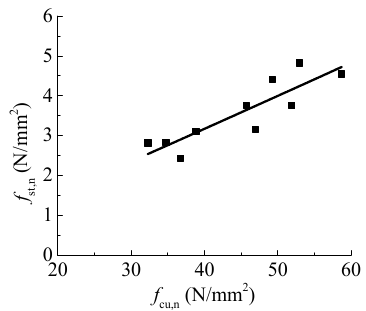
Figure 9. Relationship between splitting tensile and compressive strengths.